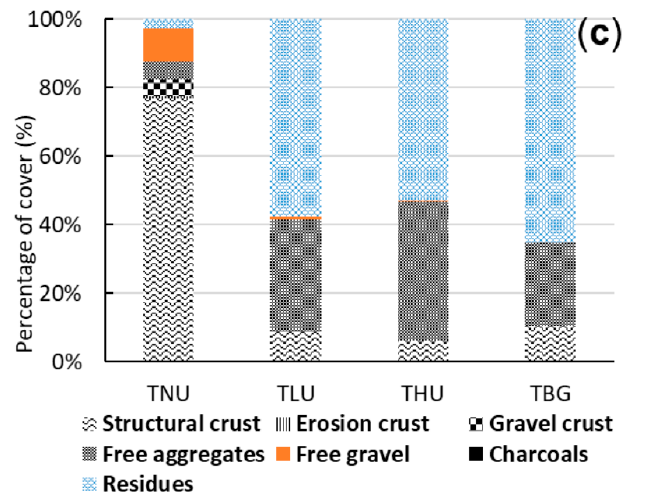
Figure 4. ( a ) Example of pedestal features circled by red lines. ( b ) Percentage of cover of pedestal features (%) and pedestal features’ height (m; logarithmic scale). ( c ) Cumulative percentage areas (%) of the soil surface features in 2017 in Ban Kokngew, Luang Prabang Province, Lao People’s Democratic Republic. TNU: teak with no understory; TLU: teak with low density of understory; THU: teak with high density of understory; TBG: teak with broom grass. Water 2020 , 12 , x FOR PEER REVIEW